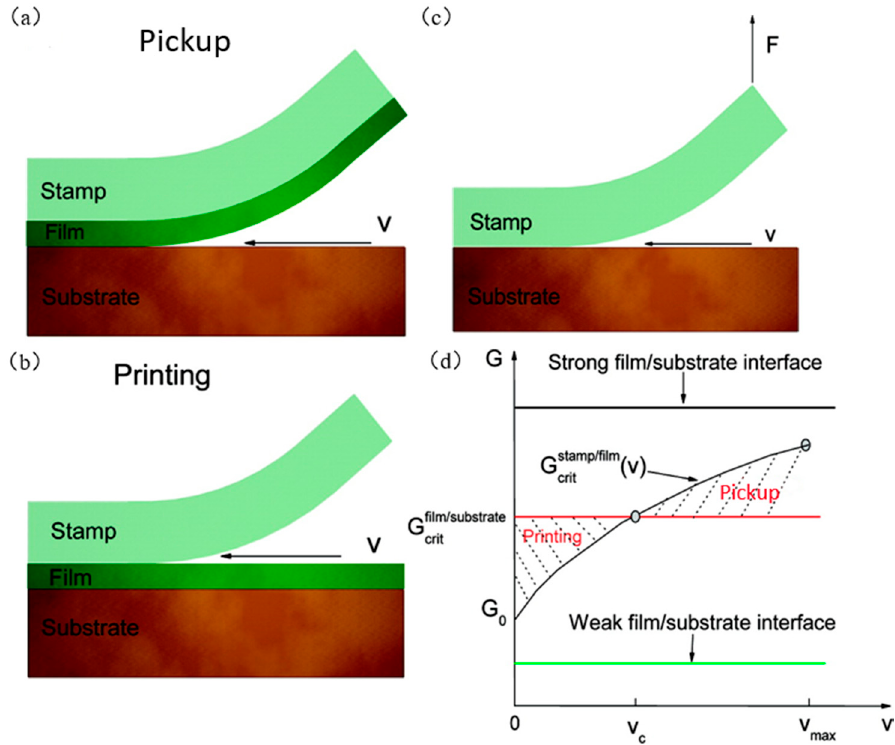
Figure 3. Kinetic control transfer printing process diagram. ( a ) Mechanical model diagram of the film extraction process (reproduced from [69]), ( b ) mechanical model diagram of the printing film process (reproduced from [69]), ( c ) schematic diagram of the separation of the seal under vertical upward pull F interface (reproduced from [69]), and ( d ) relationship between energy release rate and peeling speed (reproduced from [69]).